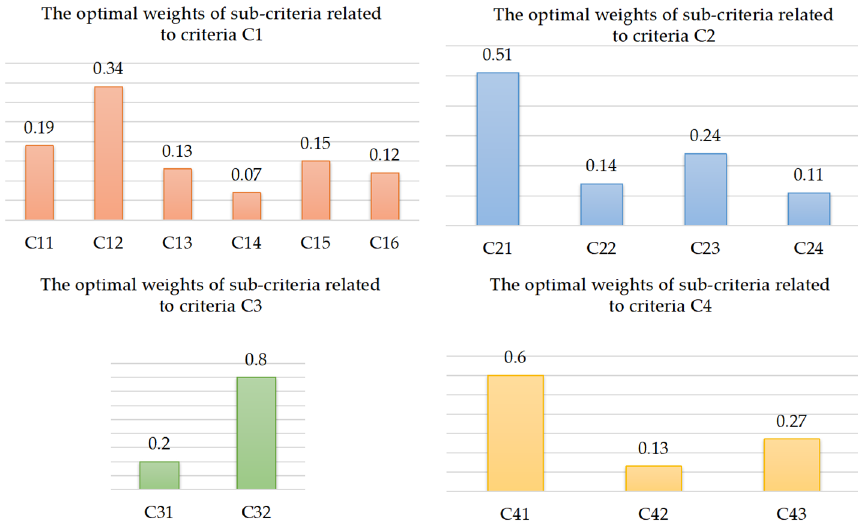
Figure 5. The optimal weights of risk sub-criteria related to each risk criteria.